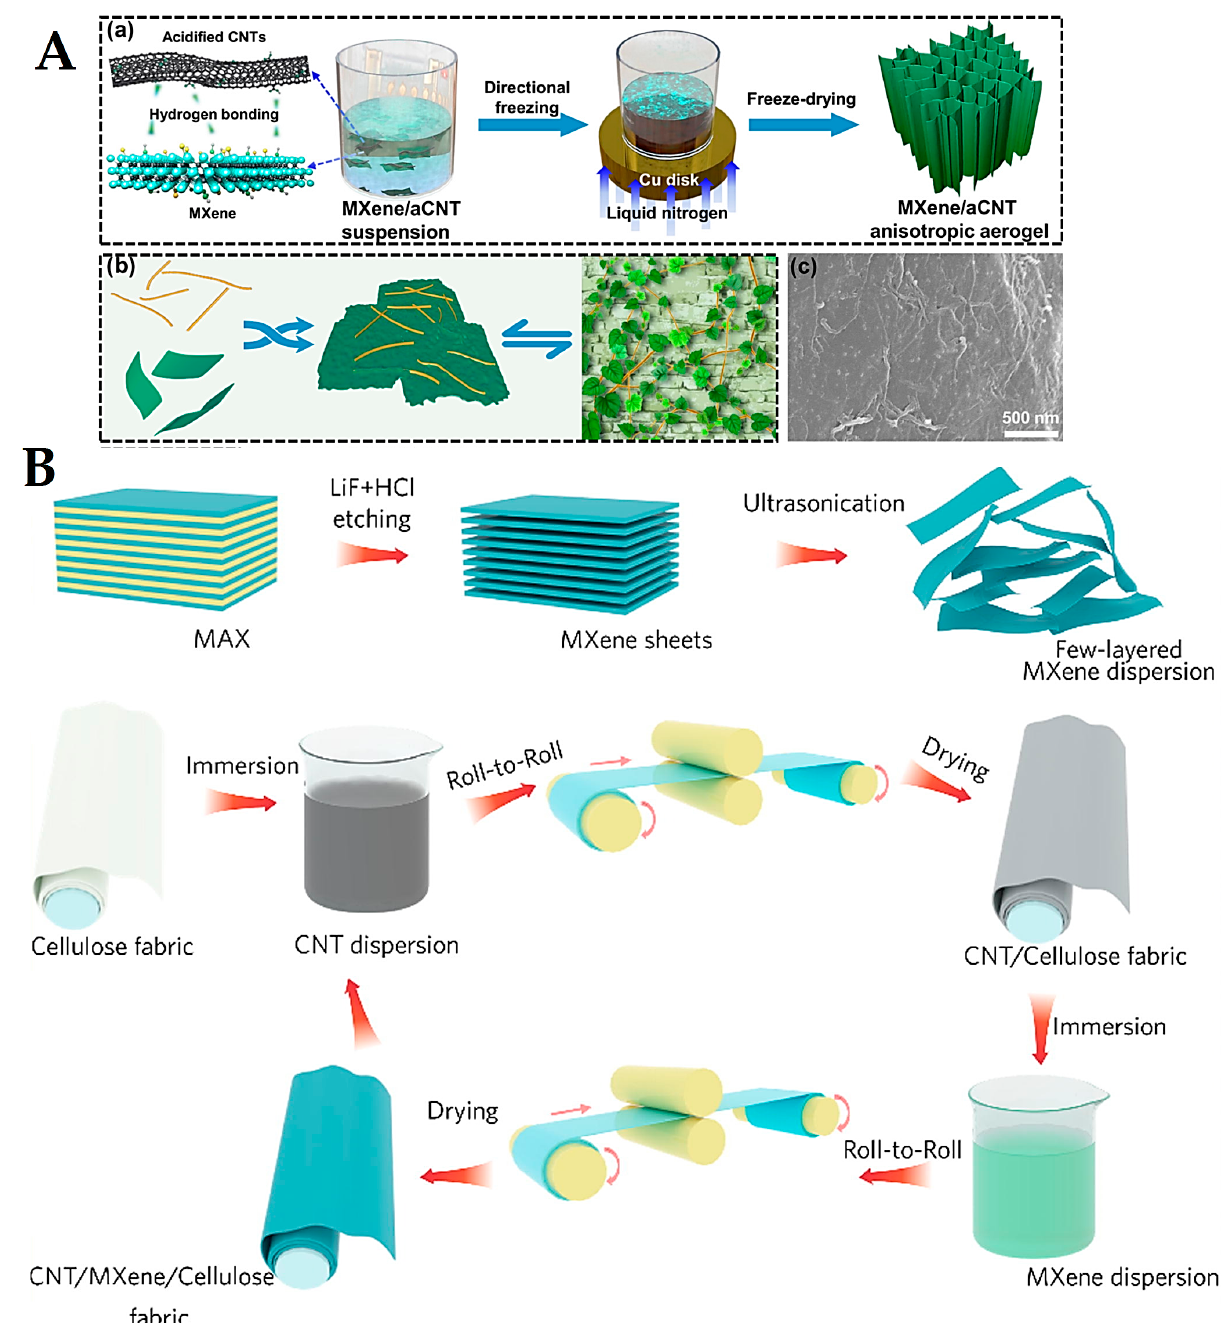
Figure 6. ( A - a ) The preparative process of MXene/CNT aerogels. ( b ) Bionic assembly between MXene nanosheets and CNTs. ( c ) SEM image of MXene/acidified CNT anisotropic aerogels with biomimetic microstructures. Adapted from Ref [99] with permission. Copyright 2021 American Chemical Society. ( B ) Roll-to-roll layer-by-layer assembly technique for fabricating bark-shaped CNT/MXene textiles with good EMI shielding performance. LiF: lithium fluoride. Adapted from Ref [101] with permission. Copyright 2021 Elsevier.